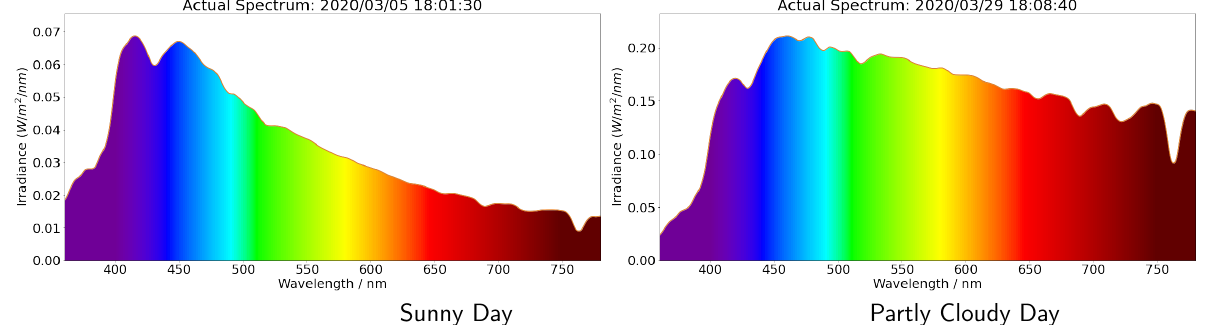
Figure 13. Spectra of solar irradiance measured by Minolta CL-500A Illuminance Spectrophotometer on a certain time, where x value is the wavelength, y value is the intensity of irradiance in unit W/m 2 /nm and the color denotes the visible color of the corresponding